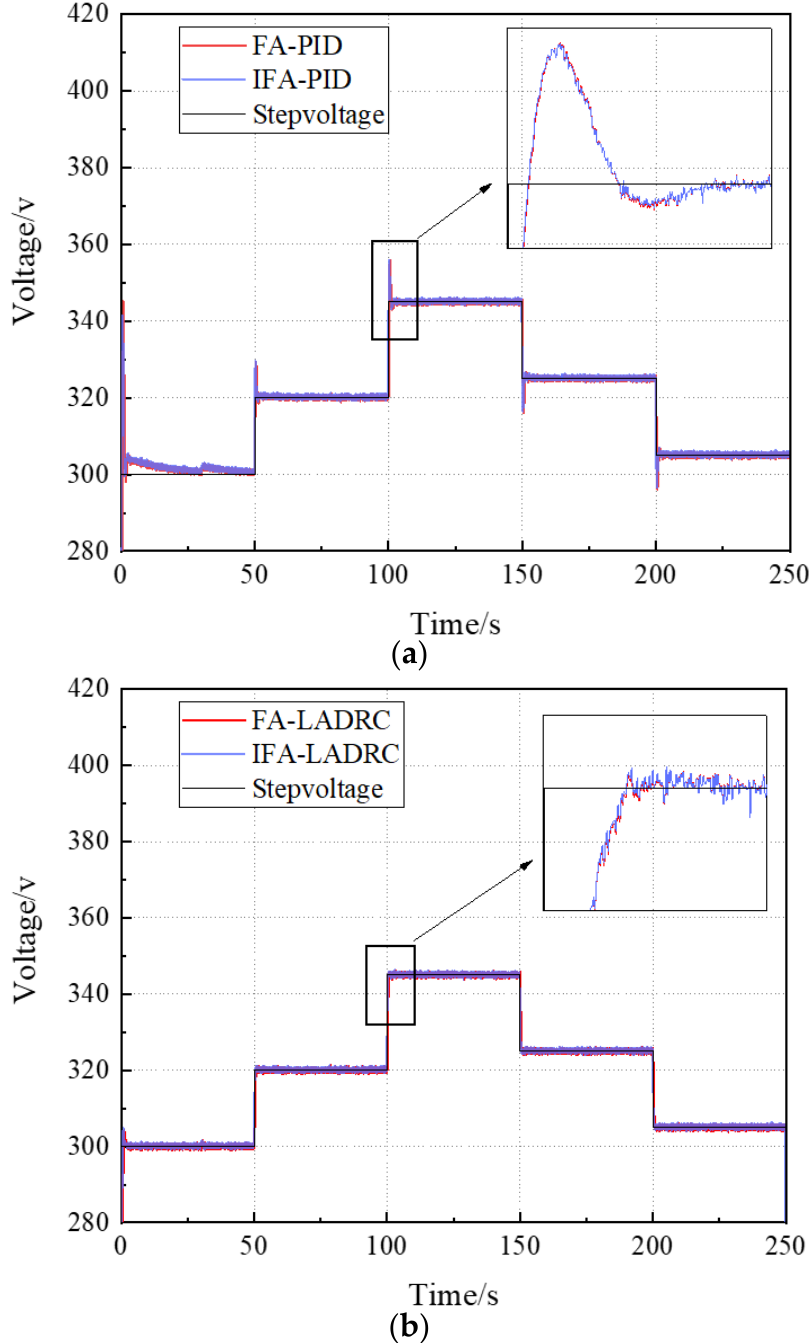
Figure 8. Voltage rise and fall response curve. ( a ) PID controller control. ( b ) LADRC controller control. Figures 9a and 9b, respectively, show the comparison of the boost and stepdown effects of the FA and IFA under the control of the PID controller. Similarly, Figures 9c and 9d, respectively, show the comparison of control effects of the FA and IFA under LADRC